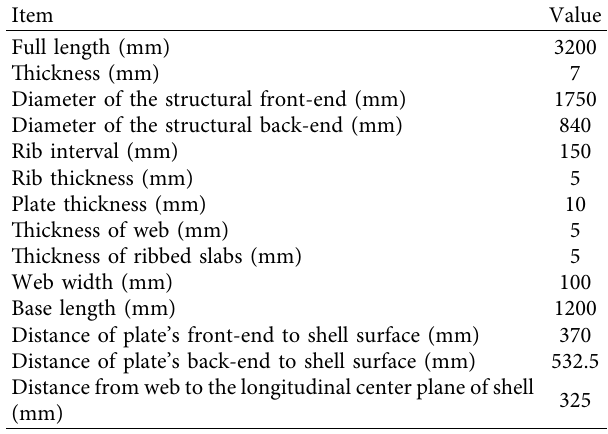
Figure 1: Finite element model. (a) Ring-stiffened conical shell. (b) Base. Table 1: Main dimensions and relevant parameters.